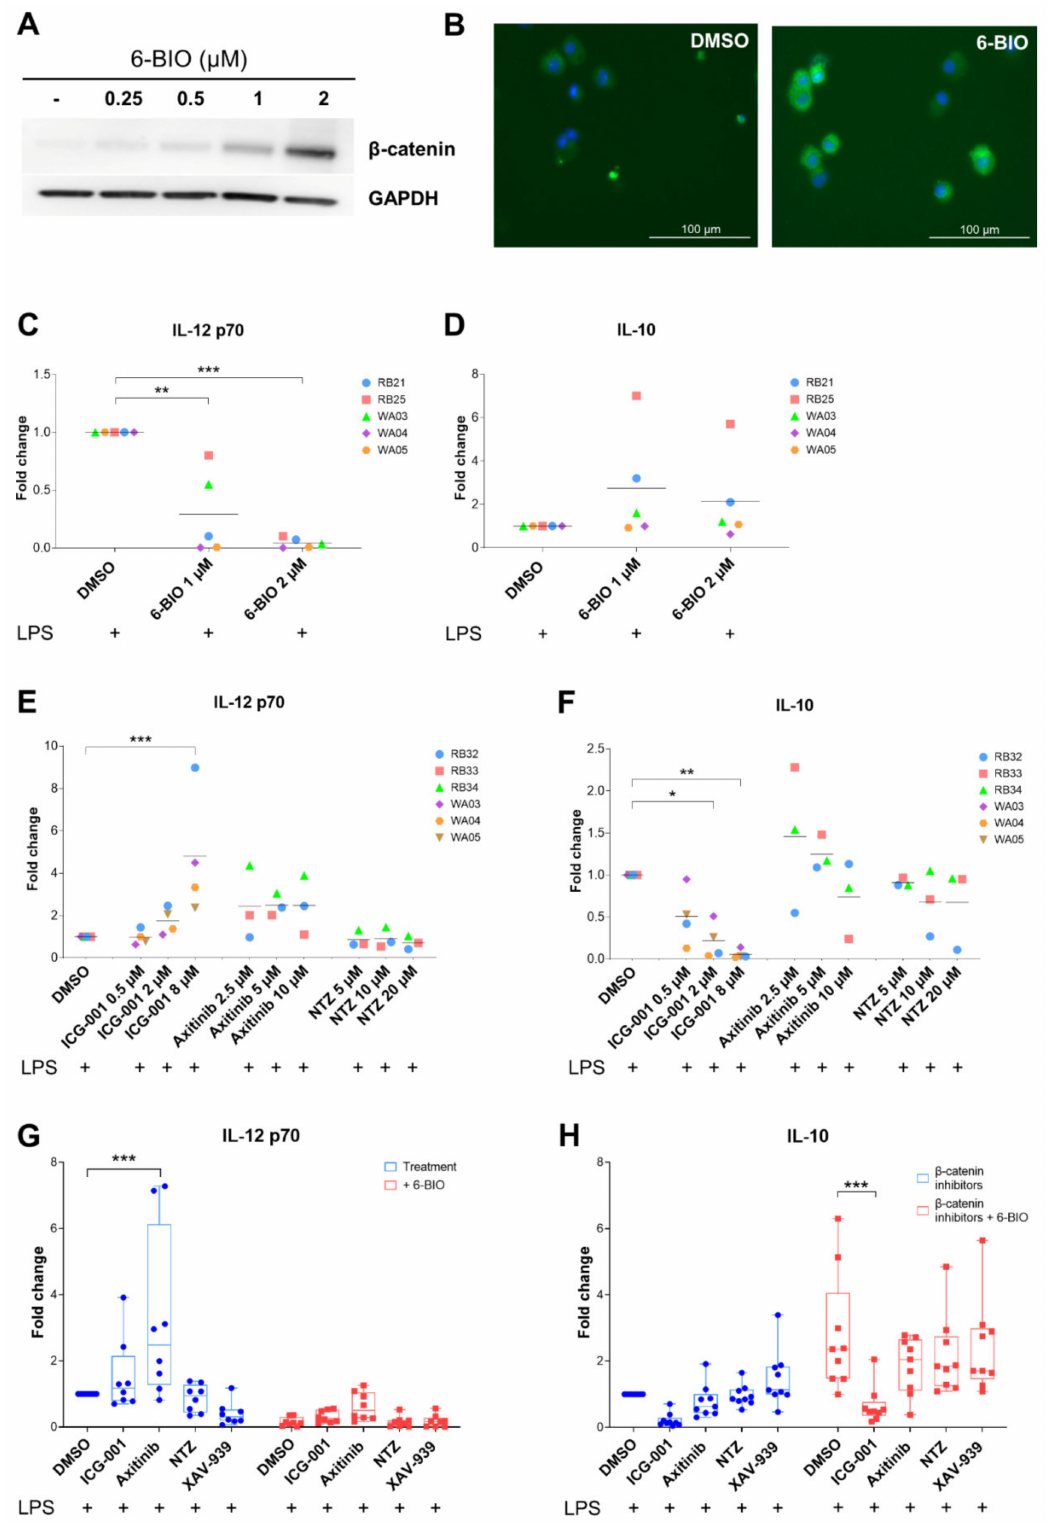
Figure 2. Immature moDCs obtained from healthy donors were treated with indicated concentrations of 6-BIO or β -catenin inhibitors with vehicle (DMSO) as control (type and concentrations as shown for ( A , C – F ) for 24 h with concomitant LPS for the last 23 h). ( A ) Western blot of whole-cell lysates. This blot is representative of 2 repeated experiments in healthy donors. ( B ) Immunofluorescence after cytospin. Cells were treated with DMSO or 2 µ M 6-BIO. This is representative of 2